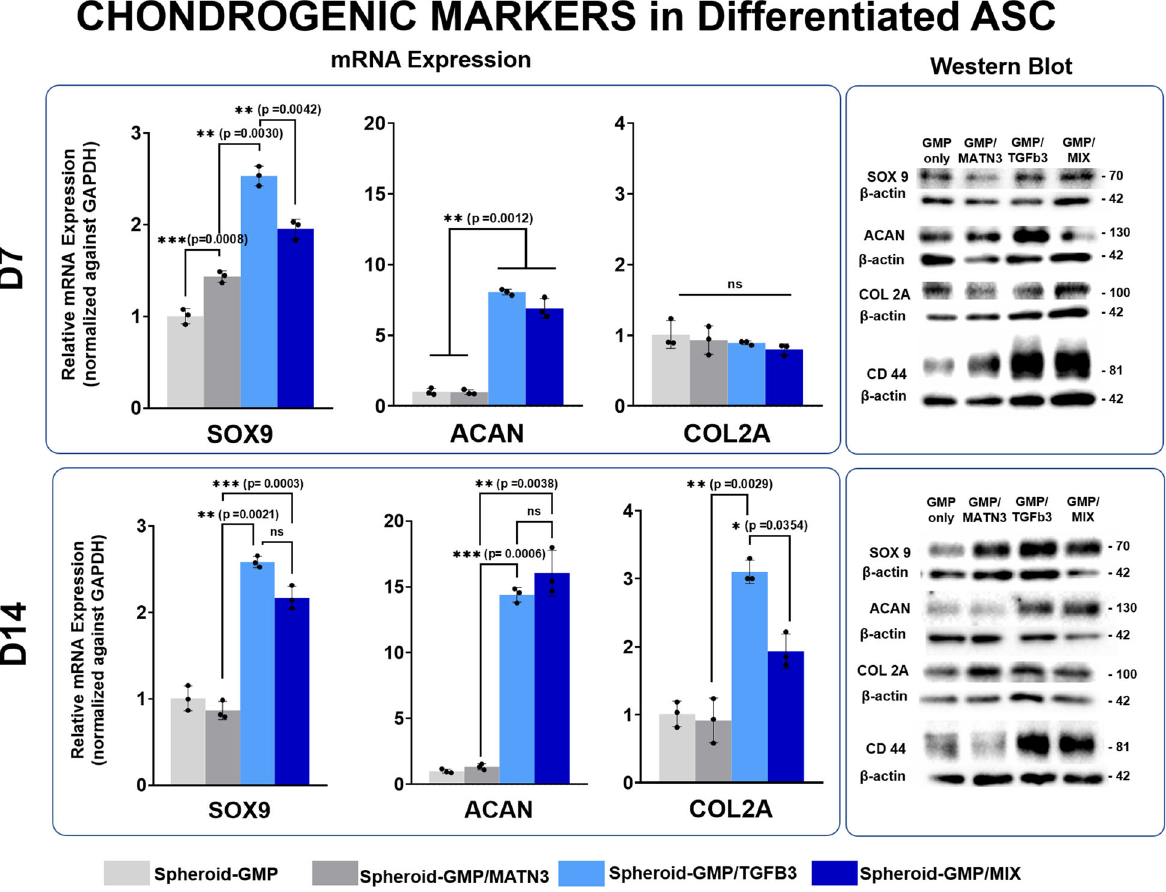
Fig. 4 Time-dependent chondrogenic differentiation of ASC spheroids. Quantitative real-time gene expression analysis and immunoblot analysis of the chondrogenic markers SOX9, ACAN, COL2A, and CD44; 7 days (top panel) and 14 days (bottom panel) post differentiation. qRT PCR data were normalized against GAPDH expression, while western blot data were normalized against B-actin control. The data are representative of three independent experiments, each experiment done in triplicate. Error bars denote the means ± standard error of mean (sem) (ns = not signi fi cant, * p < 0.05, ** p < 0.01, *** p < 0.001; **** p < 0.0001). Individual data point and p -values for signi fi cance were indicated in the